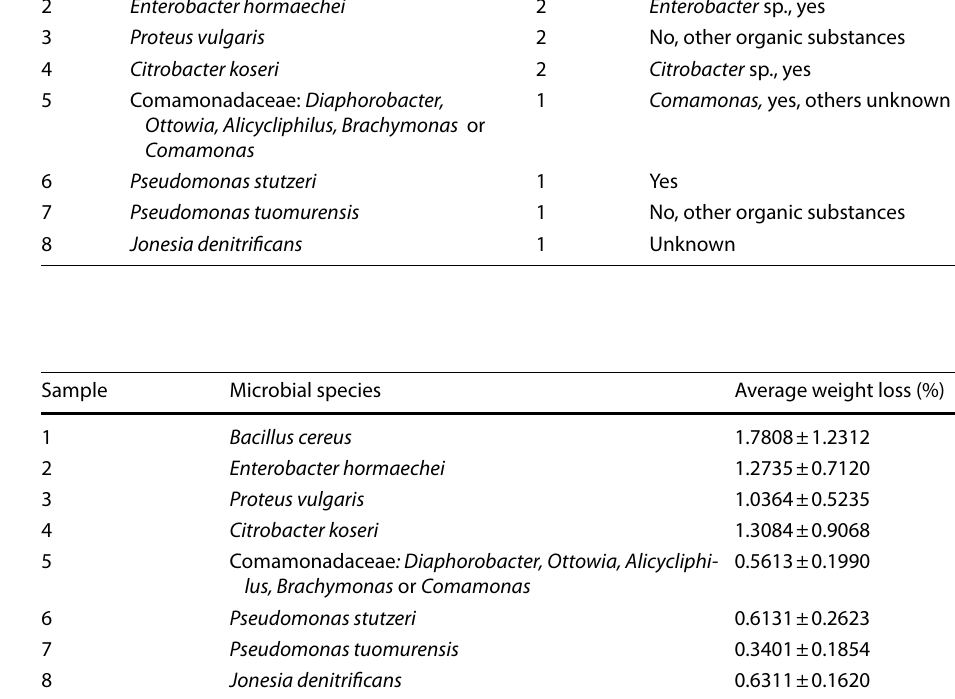
Mean of measured values ( n = 4) is shown; ± Standard